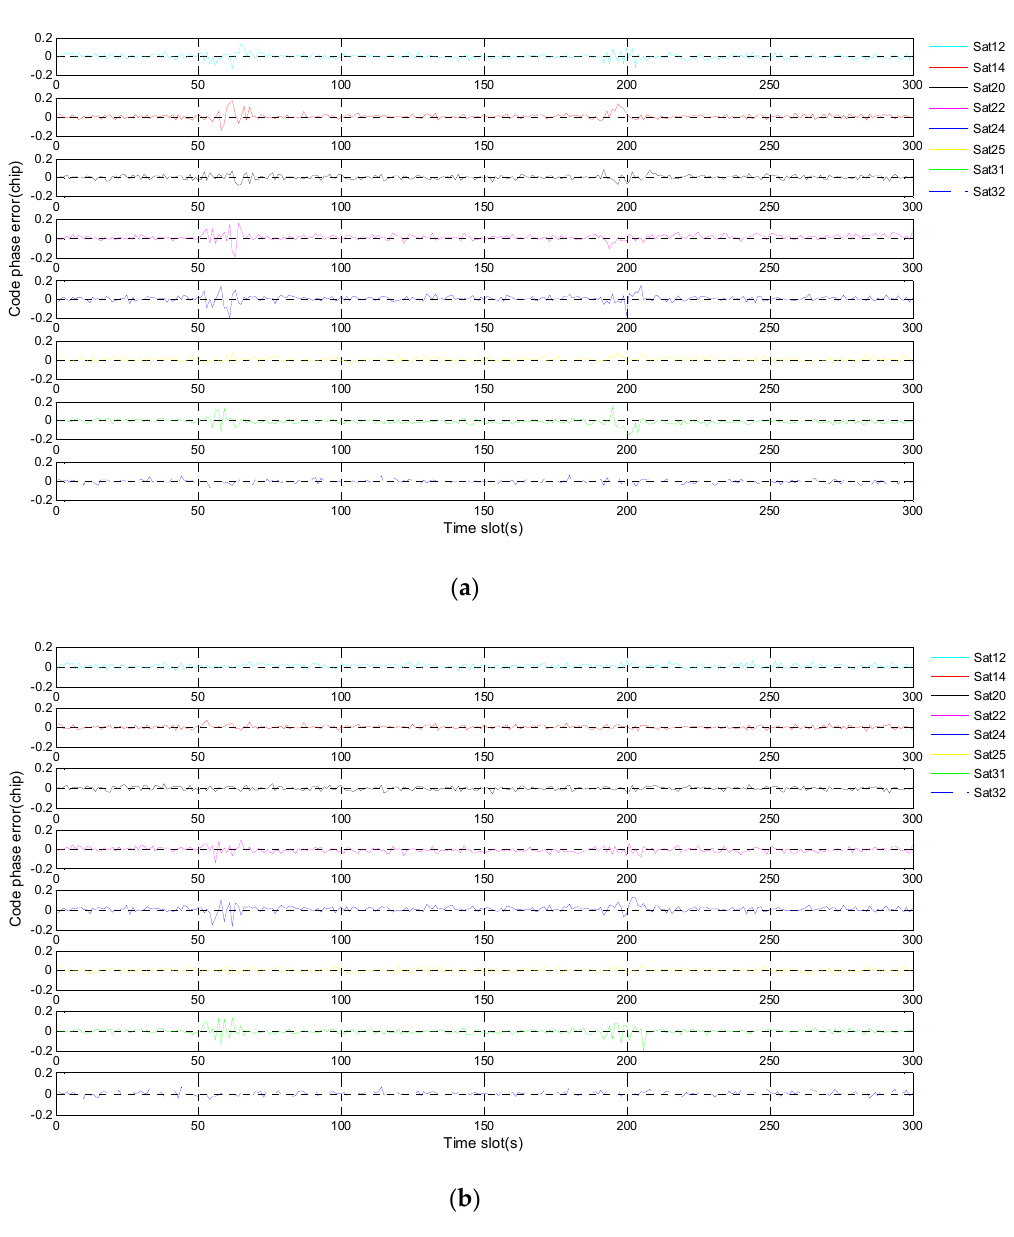
Figure 15. Code phase errors of eight satellite signals during occlusion: ( a ) before using a robust algorithm; ( b ) after using a robust algorithm.